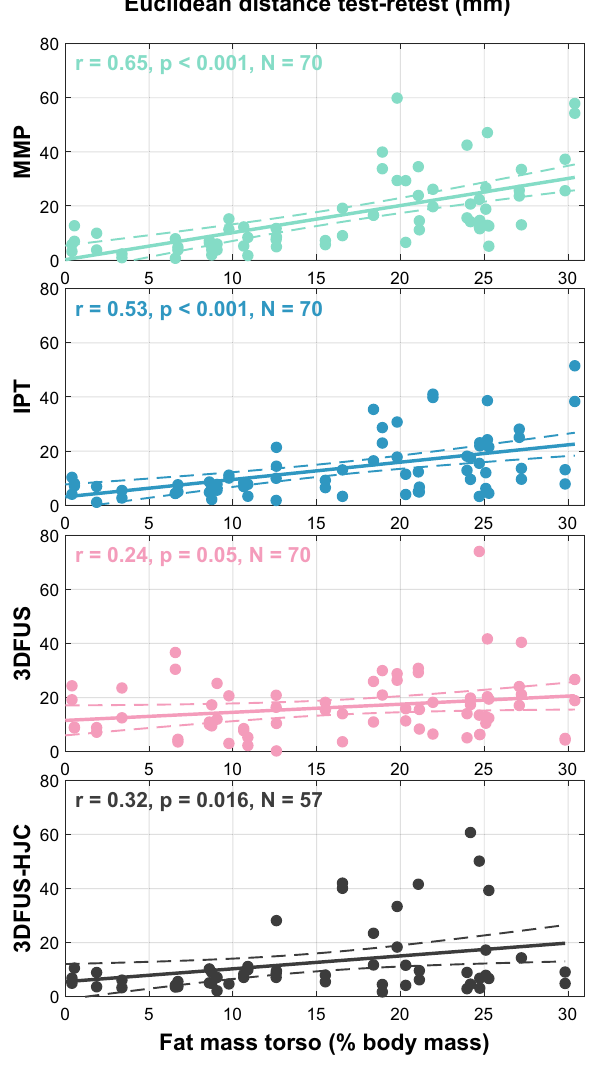
Figure 3. Euclidean distances of the anterior superior iliac spine (ASIS) and the hip joint center (HJC) location between the test and the retest plotted against the fat mass of the torso in % body mass. The first three plots show the methods, manual marker placement (MMP), instrumented pointer technique (IPT), and 3D free-hand ultrasound (3DFUS) to determine the ASIS positions. The fourth plot shows the 3DFUS-based HJC location. The solid line represents the line of best fit. The dashed lines show the 95% confidence intervals. Pearson’s r, the p values, and the number of included data points are shown for each plot. Note that 11 trials (legs) from the obese and two trials (legs) from the lean group had to be removed for 3DFUS-HJC due to problems with image quality and a technical problem,